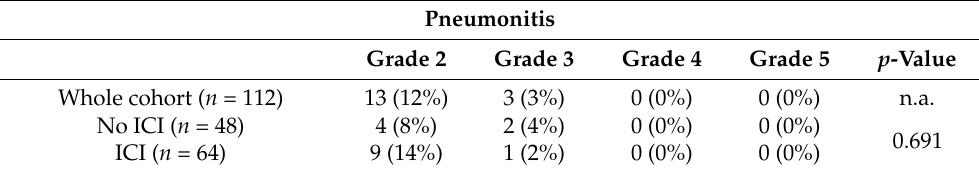
Table 3. The occurrence of clinically relevant pneumonitis, i.e., grades 2 to 5, did not differ signif- icantly between subgroups with or without ICI (=immune checkpoint inhibitor; Mann–Whitney U test, p -value =